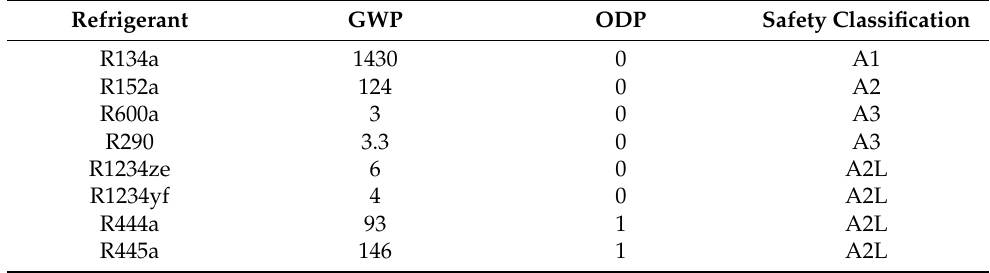
Table 1. Summary of working fluids discussed with properties. Data retrieved from RefProp